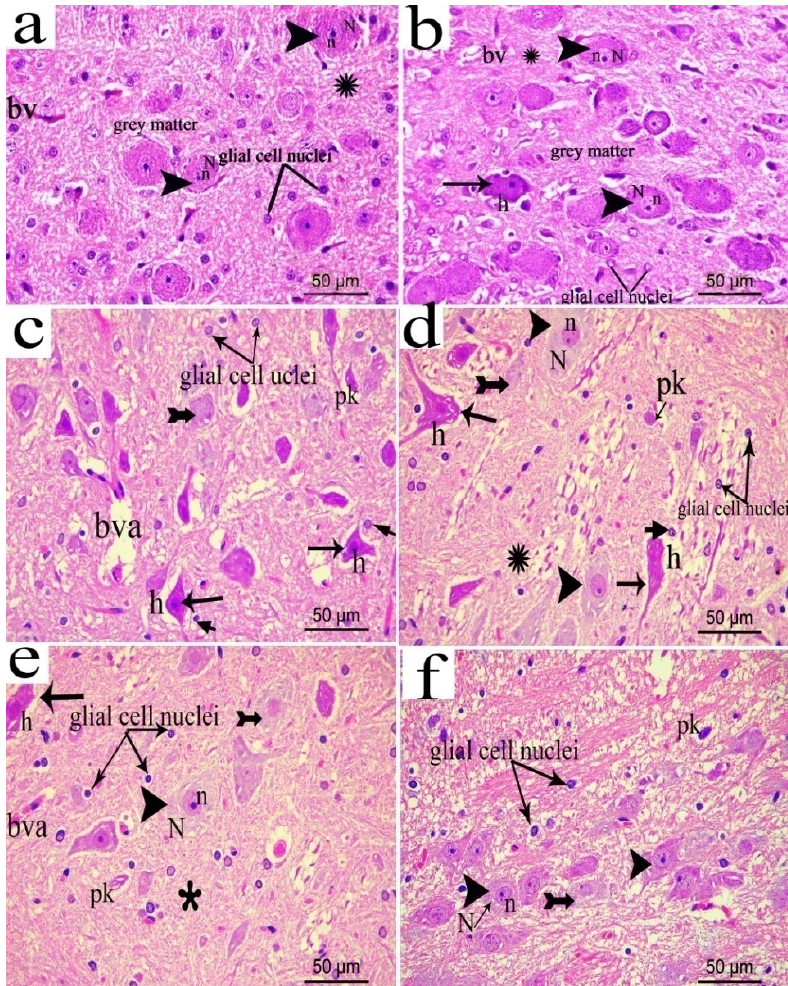
Figure 17. Representative photograph in sections of brain stem from: ( a ) normal; ( b ) sham; ( c ) CCI; ( d ) pregabalin; ( e ) H. campechianum flower extract (p.o., 200 mg/kg); and ( f ) H. campechianum flower extract (p.o., 400 mg/kg) group. Arrowhead, arrow, bifid arrow, short arrow and asterisk (*) illustrate normal neurons, affected neurons with dark stained cytoplasm and nuclei, neurons with rarified lightly stained nucleus, perineural glial cell nuclei and neuropil, respectively. bv, normal blood vessel; bva, dilated or congested blood vessel; h, vacuolation and pk, pyknotic nuclei and glial cells nuclei; N, nissl granule; n, nuclei. Scale bar, 50 μm × 400.